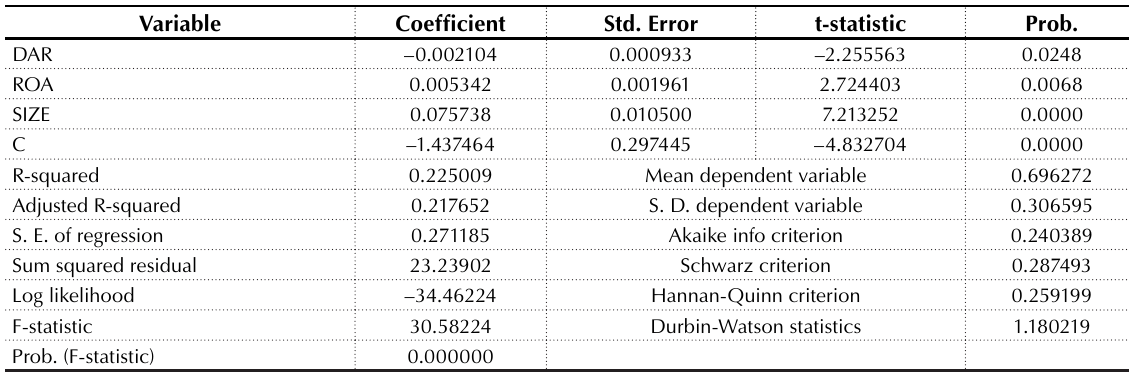
Table 1. Regression